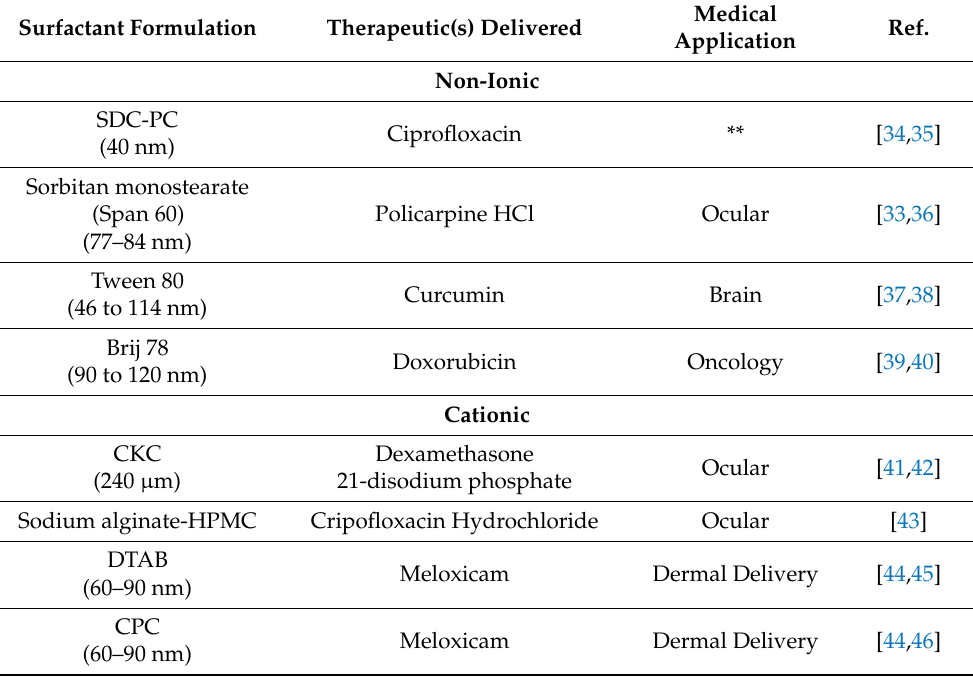
Table 1. Examples of the different types of surfactants used in drug